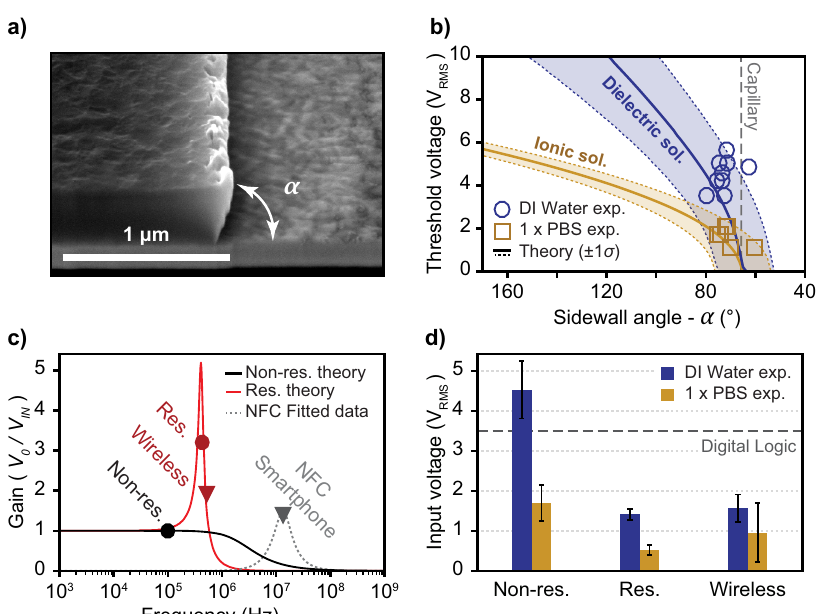
Fig. 2 Ef fi cient electrode geometry for digitally driven, wireless open-channel fl uidics. a Scanning electron microscopy (SEM) cross-section of our electrode stack after fabrication with a sidewall angle, α , clearly de fi ned. b Theoretical threshold-voltage curves were plotted as a function of α , using our measured device parameters with ±1 standard deviation. This was simulated for both dielectric (DI water) and ionic (PBS) solutions. Experimental data for both regimes are in good agreement. c The theoretical and observed voltage gain is plotted as a function of frequency for nonresonant, resonant, and wireless resonant operation. A wireless NFC circuit was also designed and powered using a smartphone to actuate PBS buffer. A theoretical curve to simulate the complex circuitry within the smartphone device was fi tted to the observed data using our known circuit elements. d The required input voltage experimentally found for DI water and PBS buffer for three different device con fi gurations: wired nonresonant, wired resonant (via a series inductor), and resonant wireless using inductively coupled coils (1 – 1.5 cm separation). With resonant operation, the input voltage for both dielectric and conductive solutions is below the threshold for a digital logic signal. Error bars are ±1 standard deviation. Source data are provided as a Source Data fi le for Fig. 1b,